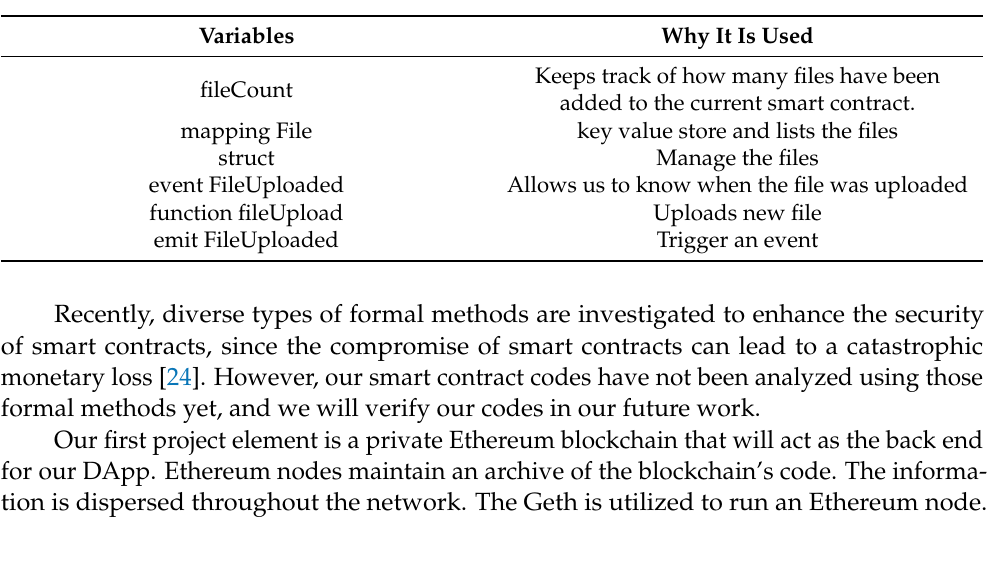
Table 2. Smart Contract